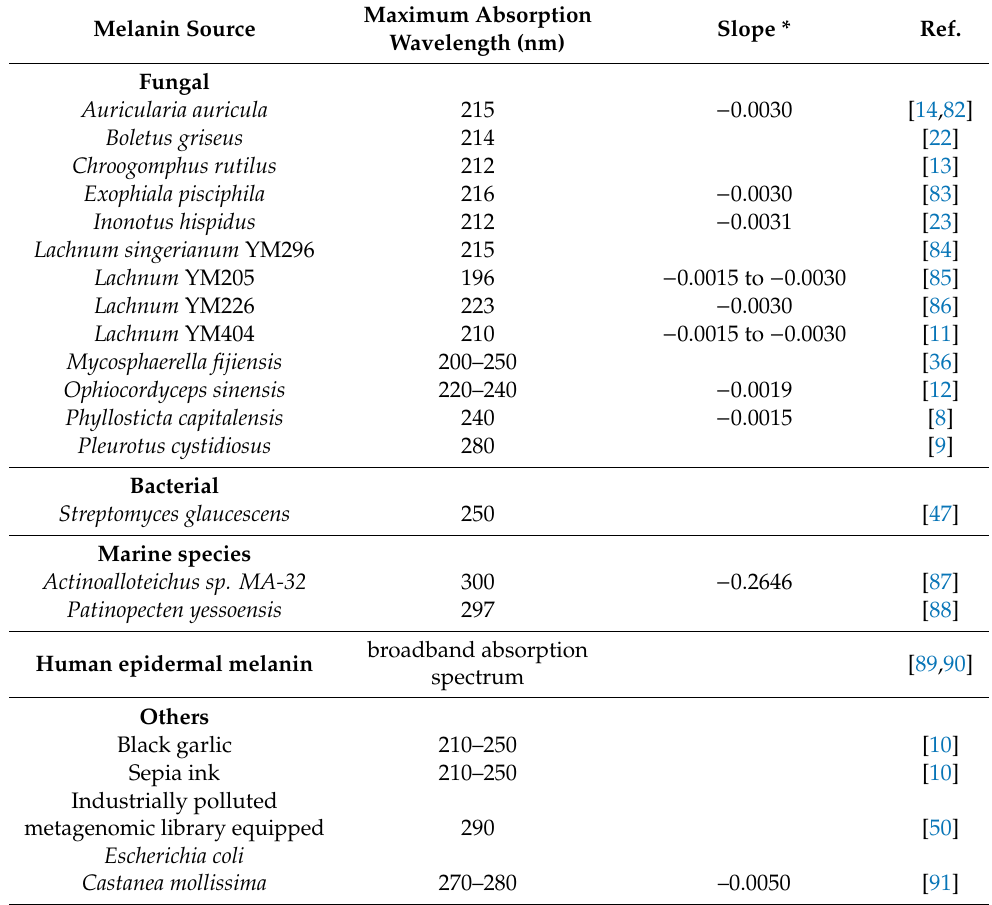
Table 6. The UV-VIS spectra characteristics for di ff erent types of